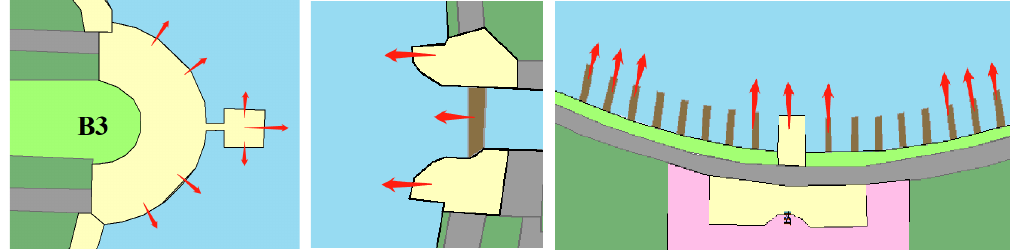
Figure 9. Convex shoreline, horizontal + convex shoreline, and concave + convex shoreline.